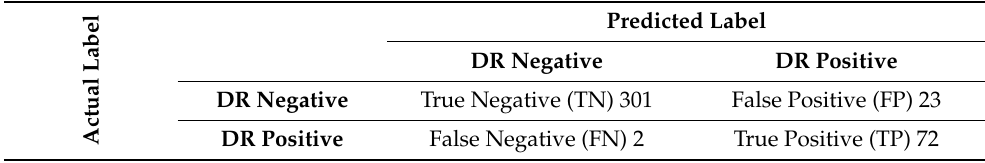
Table 4. Confusion matrix of Diabetic Retinopathy model after being reviewed by clinical experts.